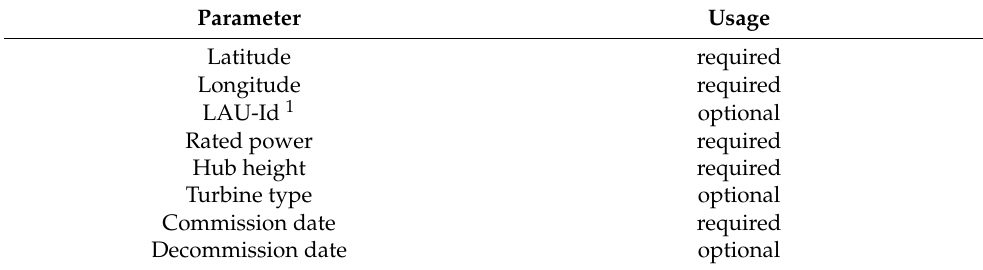
Table 1. Parameters of the turbine dataset used for the wind power model.